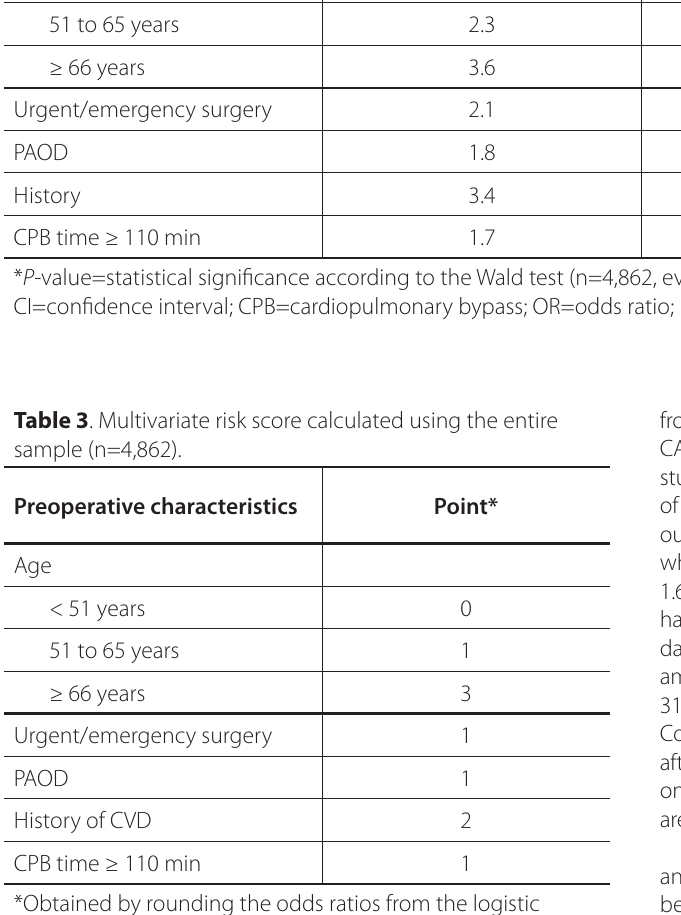
model for the entire sample. CPB=cardiopulmonary bypass; CVD=cerebrovascular disease; PAOD=peripheral arterial occlusive